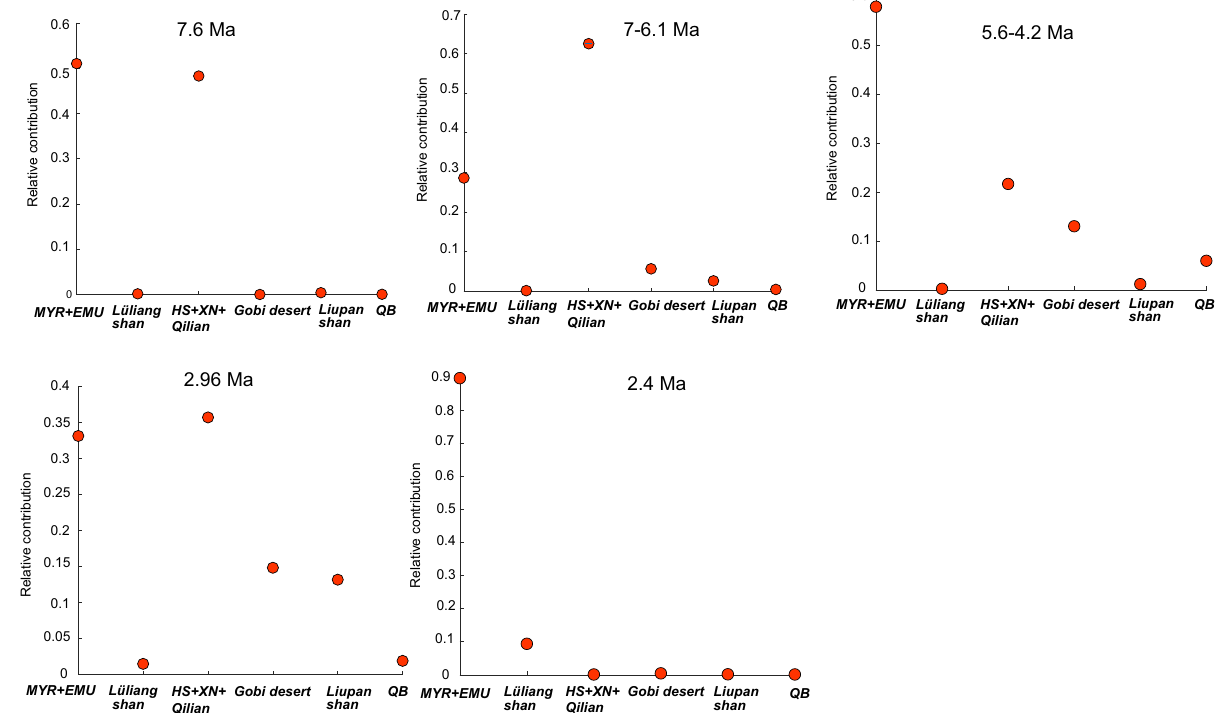
Fig. 5 The relative contribution plots of potential sources to loess and Red Clay in JX. Red dots show the best-estimated contributions of different potential sources in the optimized simulation model. MYR Middle Yellow River sediment, EMU Eastern Mu Us Desert. HS Huangshui River sediment, XN Xining Basin sediment, QB Qaidam Basin